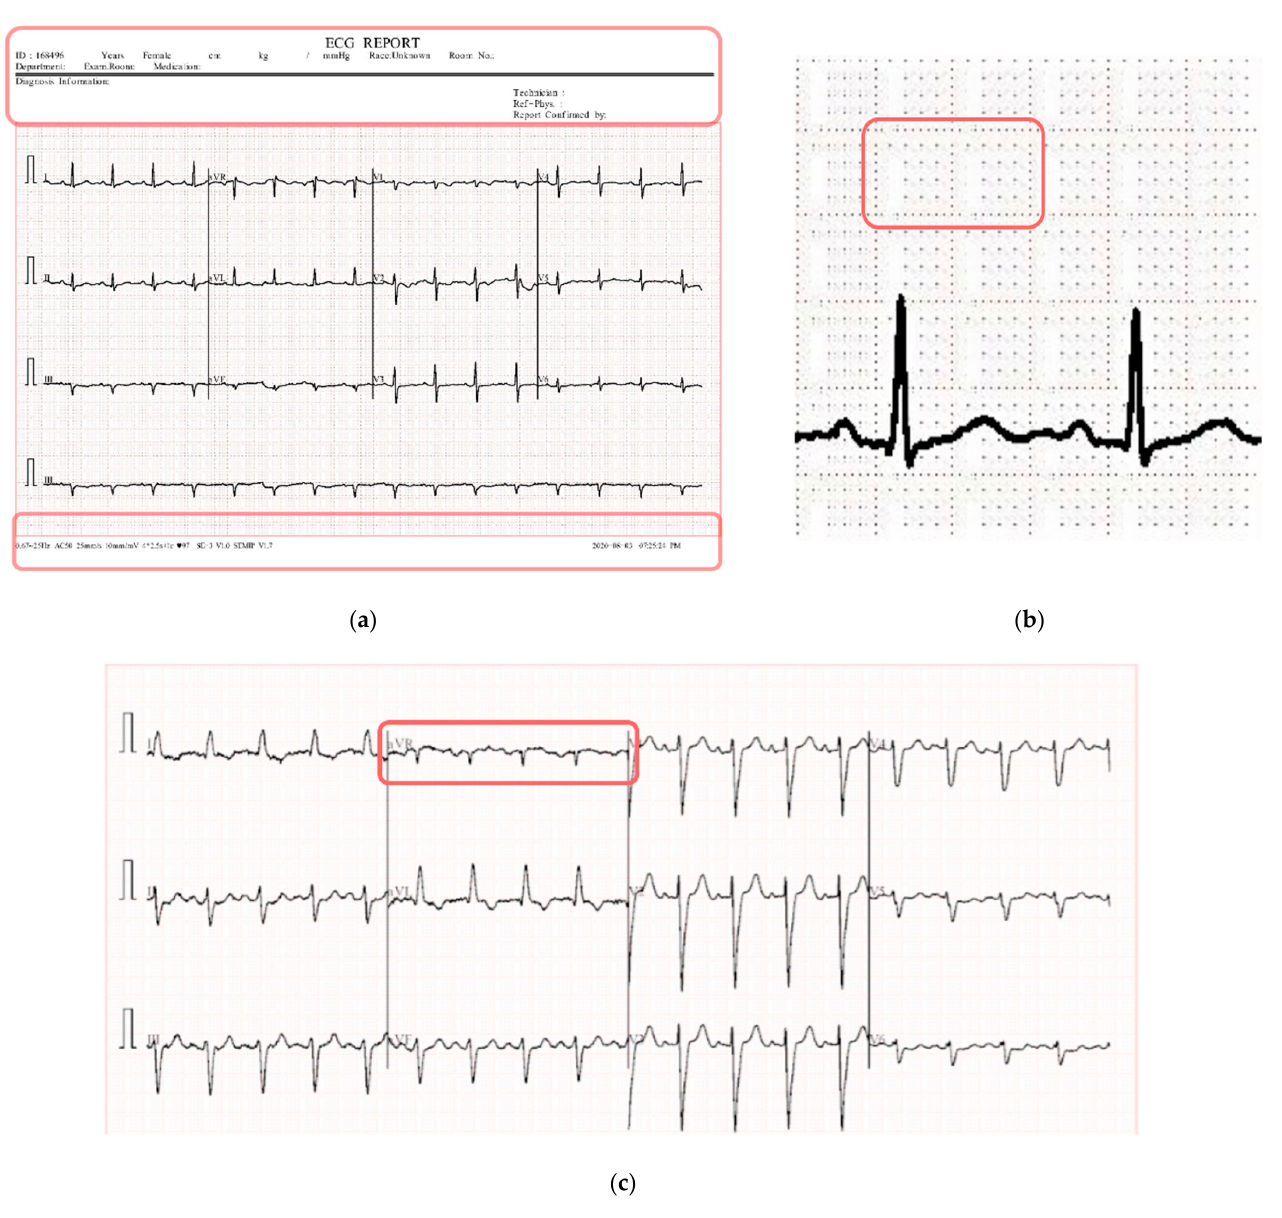
Figure 3. Challenges of the paper-based ECG image dataset ( a ) Different artifacts, ( b ) Background lines, and ( c ) Low contrast images are present in most classes.